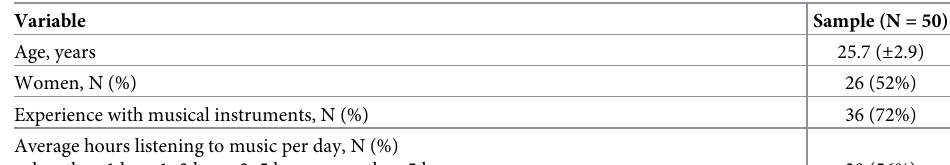
Table 1. Participants’ demographic characteristics.